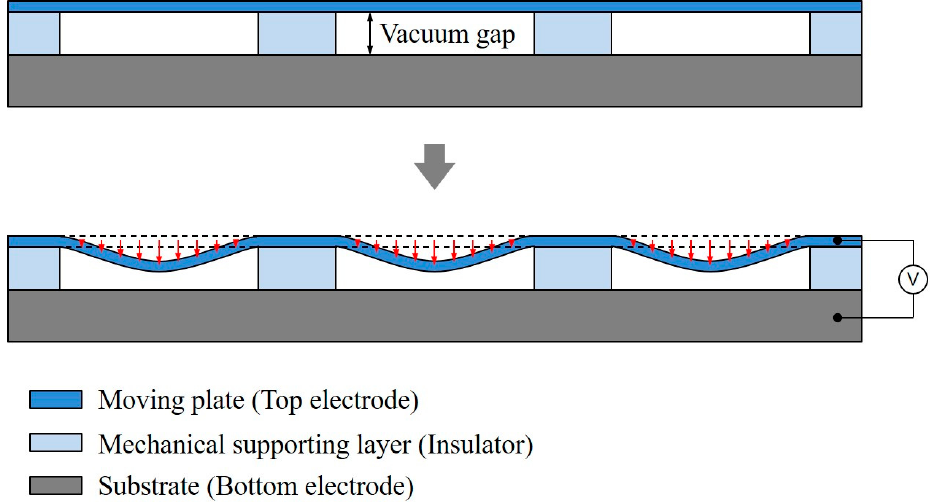
Figure 1. Cross-sectional schematic drawings of an element with 3 cells of a conventional capacitive micromachined ultrasonic transducers (CMUT). ( Top ) Initial state before applying DC and AC voltage, and ( Bottom ) flexural deformation of the moving plate due to electrostatic force.